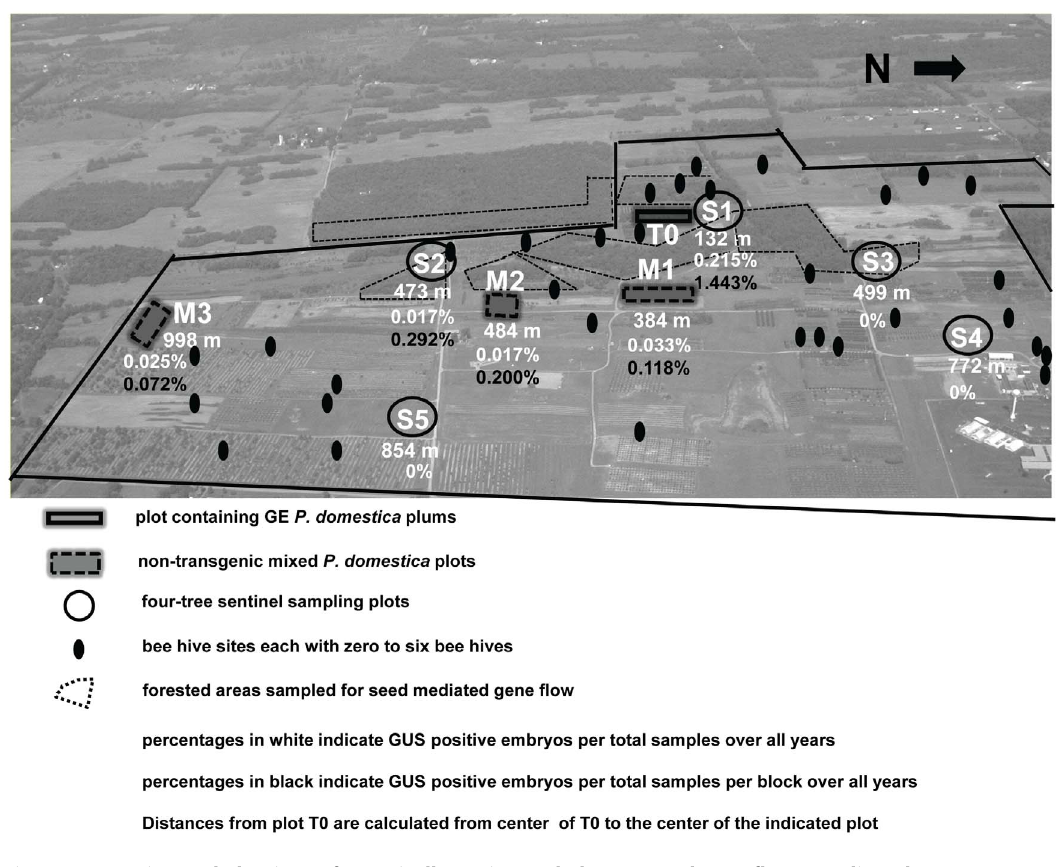
Figure 2. Experimental plantings of genetically engineered plums T0 and gene flow sampling plots (S1–S5; M1–M3). A total of 12,116 seeds were sampled for GUS assays over 11 years. Distances of sample plots from plot T0 and % GUS positive seeds/total seeds (white numbers) and